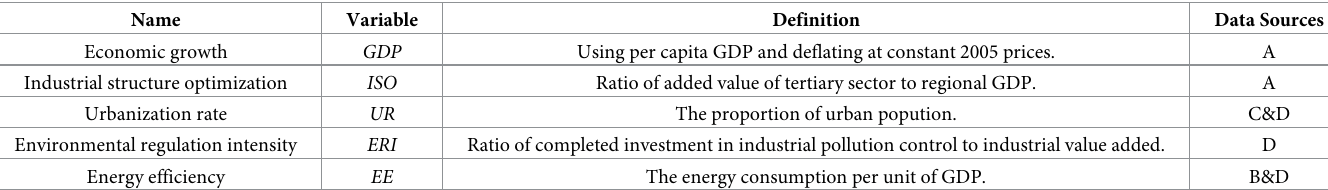
Tables 3 and 4 respectively list the regression results of the test models (Eqs (1) and (2)) for the impact of urban-rural income gap on carbon emission reduction and pollution control. Col- umns (1) and (2) show the estimation results of the random effects model (RE). Columns (3) and (4) show the estimation results of the fixed effects model (FE). From F-test results, it can be seen that the individual effect is significant, while the fixed effect is better. The result of Hausman indicates that unobservable individual effects are associated with the explanatory Table 1. Description of control